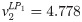
Bursting orbit of system (3).(a) Solution of (3) (blue orbit) and L0 (red curve) on the critical surface S0(green surface) projected on the (v0, v2, v3)-space. Single-headed, double-headed and triple-headed arrows indicate the flow direction during superslow, slow and fast time-scales, respectively. LP denotes limit point bifurcation. The L0 curve changes stability at two limit points, LP1 and LP2 (red dots). The middle branch of the L0 curve between these limit points is unstable (dashed). (b) Time course of the variables (v3, v0, v2) of the orbit plotted in panel (a). (c) Solution of (3) projected on the bifurcation diagram (black curve) of (4) for ε = 0 where v2 is threaded as a parameter. Arrows show the direction of the flow with respective time-scales. Bold and dashed lines correspond to stable and unstable solutions, respectively. H donates a Hopf bifurcation, LP a limit point bifurcation. The equilibrium points along the black Z-shaped curve are unstable on the middle branch of the curve, between LP1 at v2LP1=4.778 and LP2 at v2LP2=20.66 (black dots), and on the upper branch between H1 at v2H1=0.27 and H2 at v2H2=14.27 (green dots). The amplitude of the stable limit cycles is bounded by the green continuous curves connecting the H1 and H2 in the ε = 0 limit.